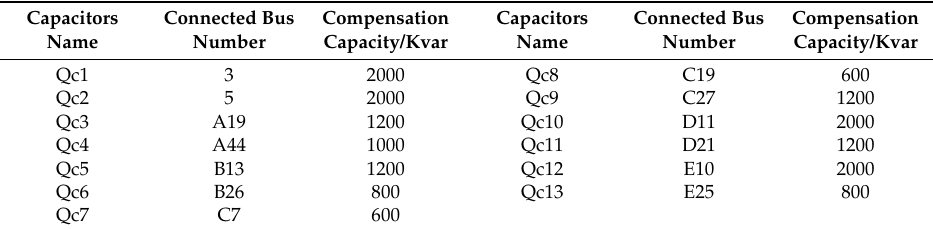
Table 1. The configuration of capacitors in 173 nodes system.